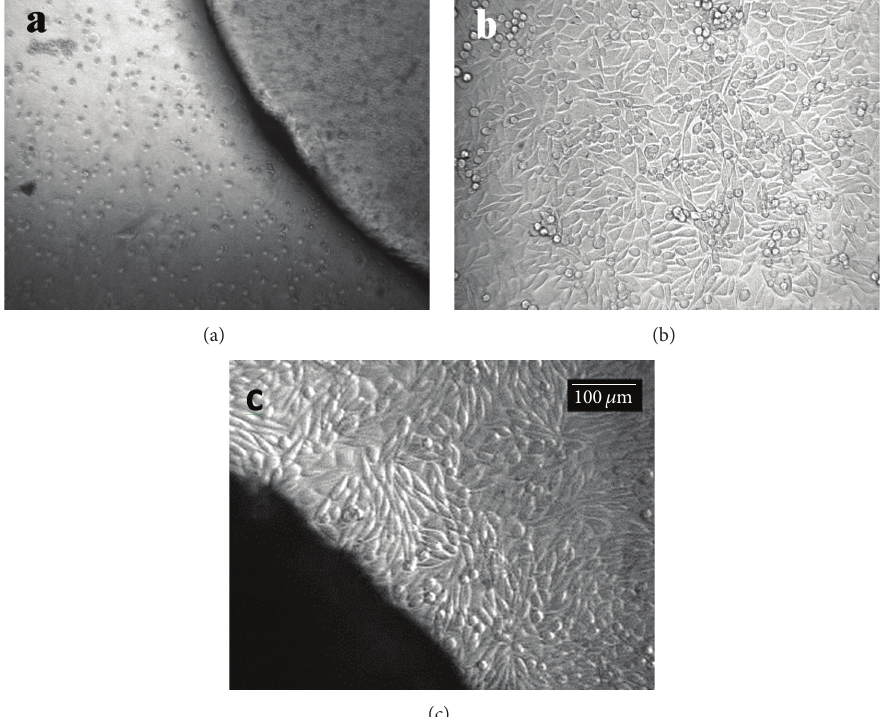
Figure 4: L929 cells incubated with (a) positive control, (b) negative control, and (c) 50 :50 blend of TPU: PDMS containing 5pbw of compatibilizer over 24 h.